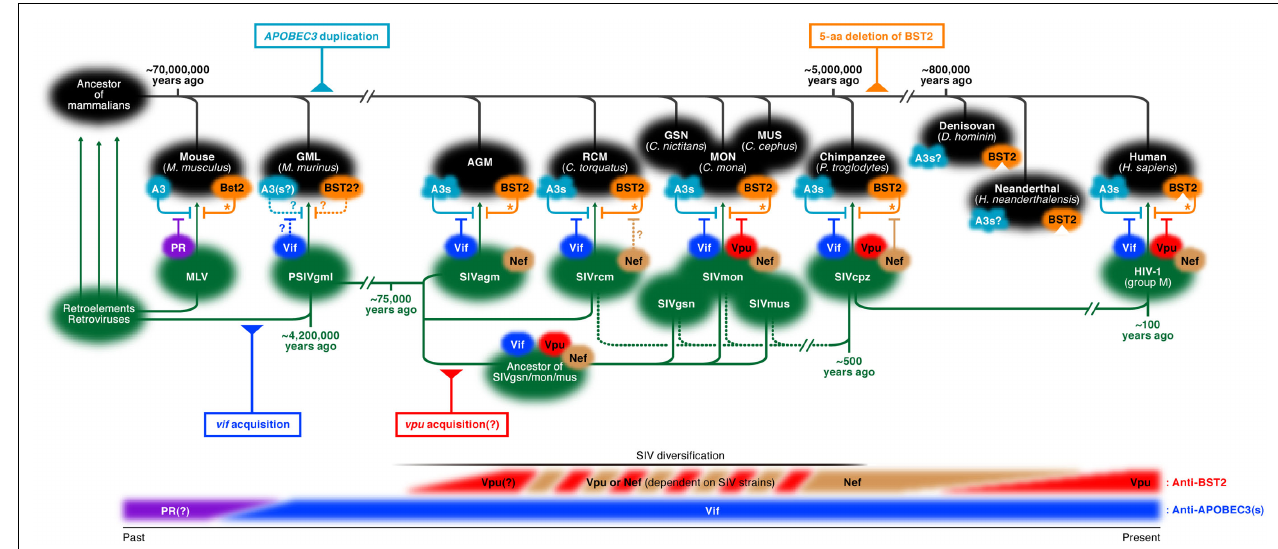
FIGURE 1 |The pedigree chart of the interplay between viral factors (Vif andVpu) and host factors (APOBEC3s and BST2) during co-evolution and co-divergence of retroviruses, lentiviruses, and hosts. Note that the timescales of hosts (top, shown in black ) and viruses (middle, shown in green ) are not parallel. (Top)The pedigree chart of hosts. Rodents including mice ( Mus musculus ) brunched almost 70 million years ago (Eizirik et al., 2001), and gray mouse lemurs (GML; Microcebus murinus ) then came into existence. After the divergence of old world monkeys [e.g., African green monkey (AGM), red-capped mangabey (RCM; Cercopithecus torquatus ), greater spot-nosed monkey (GSN; Cercopithecus nictitans ), mona monkey (MON; Cercopithecus mona ), and mustached monkey (MUS; Cercopithecus cephus )], chimpanzees ( Pan troglodytes ) evolved almost 5 million years ago (Chen and Li, 2001).Two hominids, Neanderthal ( Homo neanderthalensis ) and Denisovan ( Denisova hominin ), brunched around 800,000years ago (Krause et al., 2010; Reich et al., 2010), and then, humans ( Homo sapiens ) appeared. Regarding host factors, the duplication of APOBEC3 occurred before the divergence of old world monkeys (AGM, RCM, GSN, MON, and MUS; it is unclear whether multiple APOBEC3 s are encoded in the genome of GML). On the other hand, after the divergence of chimpanzees, the 5-aa deletion was inserted in the cytoplasmic tail of BST2. Note that BST2/Bst2 is able to impair the release of viruses while it is unable to completely restrict their replication (indicated by asterisks). (Middle)The pedigree chart of retroviruses including lentiviruses. MLV, a retrovirus, counteracts murine Apobec3 (A3) by its protease (PR). Since PSIVgml, a common ancestor of all